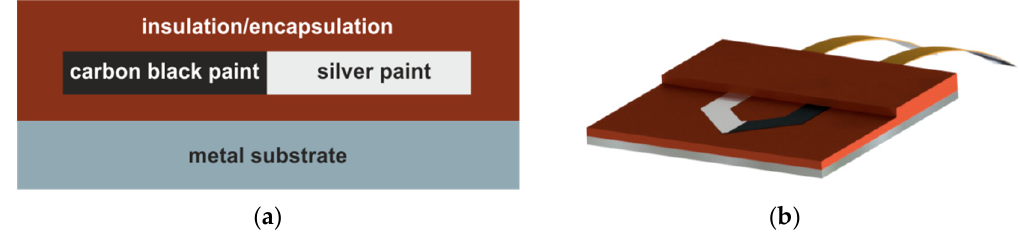
Figure 1. ( a ) Schematic architecture of the embedded thermocouple. The metal substrate is coated with a polyamide-imide insulation layer on which the thermocouple (consisting of the carbon black paint and the silver paint) is processed. The top layer is made out of the same material as the insulation ( b ) schematic representation of the embedded thermocouple. The polyimide connections (depicted in orange) are coated with the carbon black or the silver